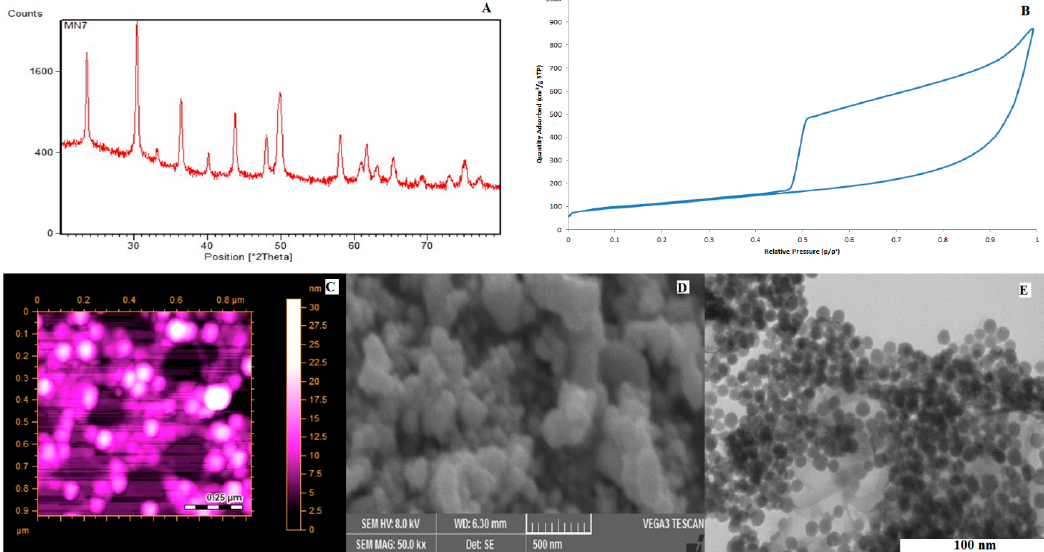
Figure 1. ( A ) XRD, ( B ) BET, ( C ) AFM, ( D ) SEM, and ( E ) TEM of the Co 3 O 4 @TiO 2 composite.